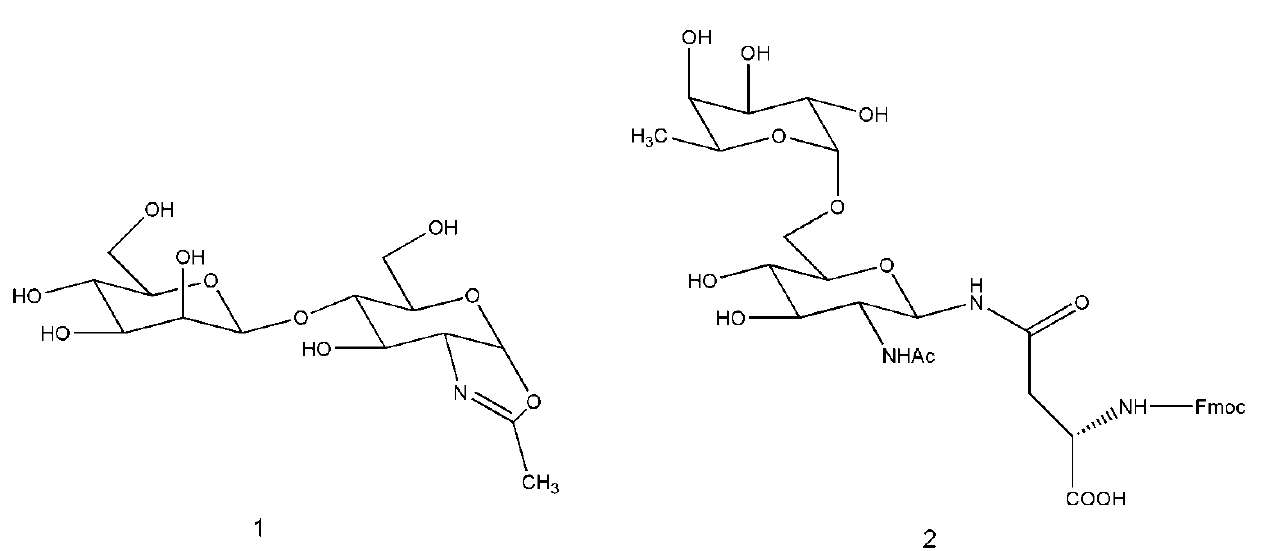
Figure 3. Typical oxazoline substrate 1 reacting with Endo-M or Endo-A and capped α-1,6-fucose (1,6-fucosyl-GlcNAc derivative) used as acceptors for transglycosylation by Endo-F2 and Endo-F3